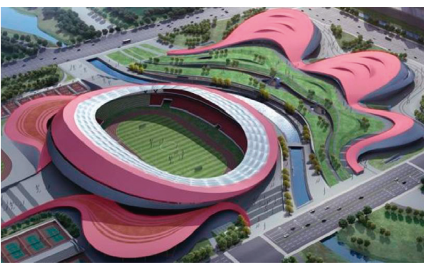
Figure 6: Leshan Olympic Center, Sichuan province.